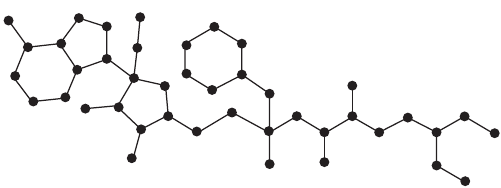
Figure 7: Molecular graph of